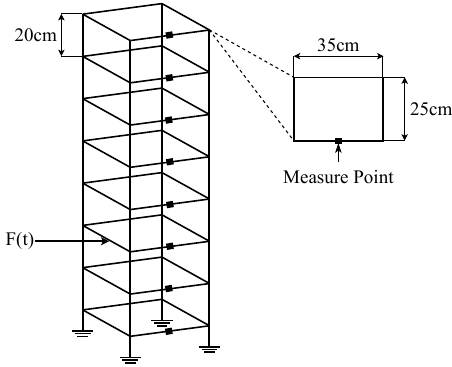
Figure 3. Eight-layer steel frame